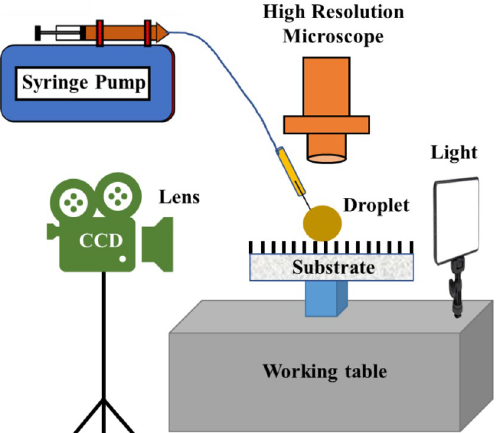
Figure 4. Schematic of the experimental setup for the wetting transition